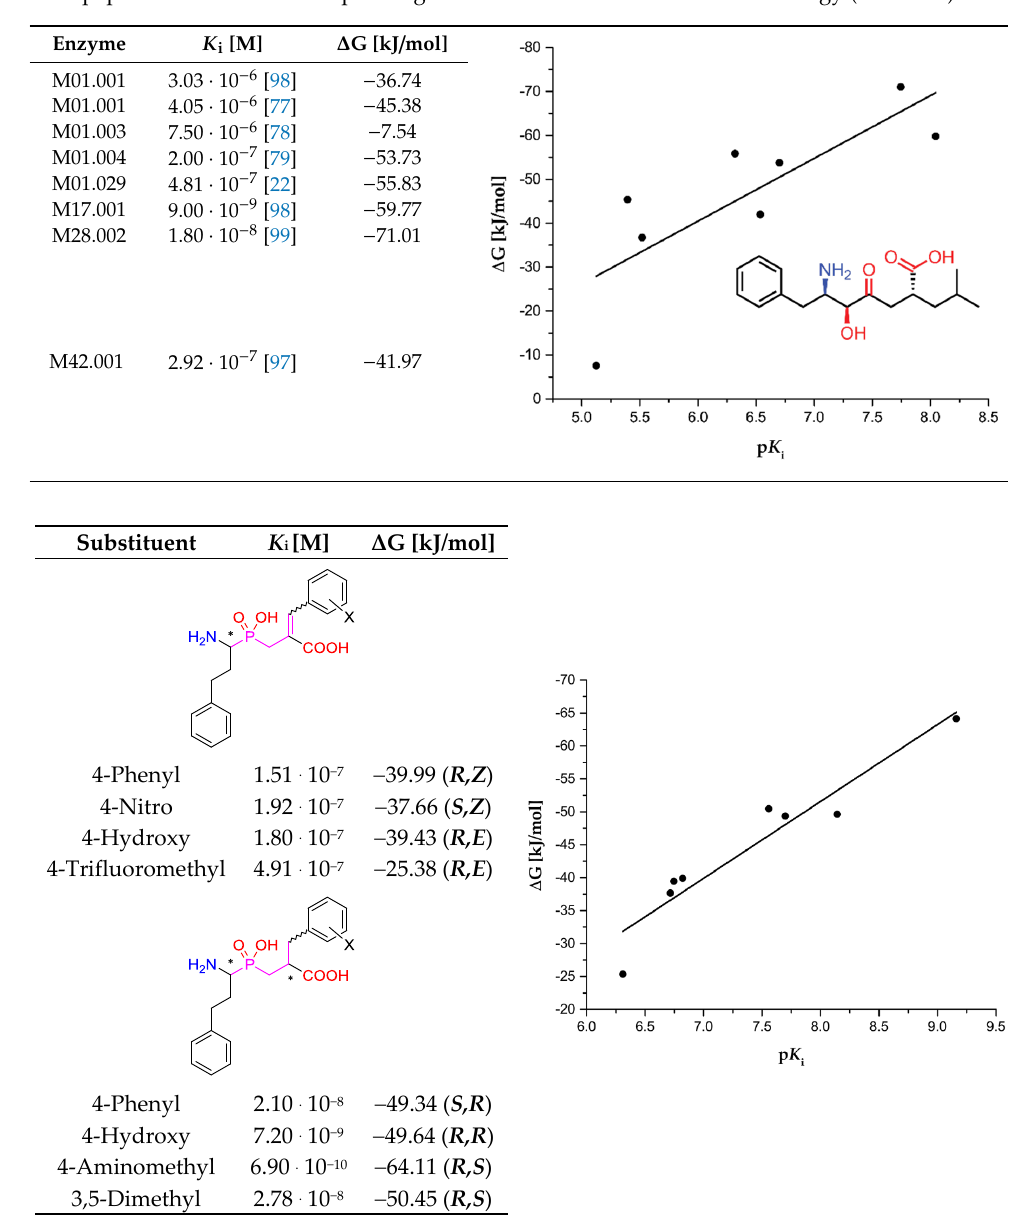
Figure S1. Modeled binding mode of a phosphinic dipeptide analog containing a 5-amino-thiophen-2-yl P1′ fragment in the active center of human aminopeptidase N (PDB: 4FYT);